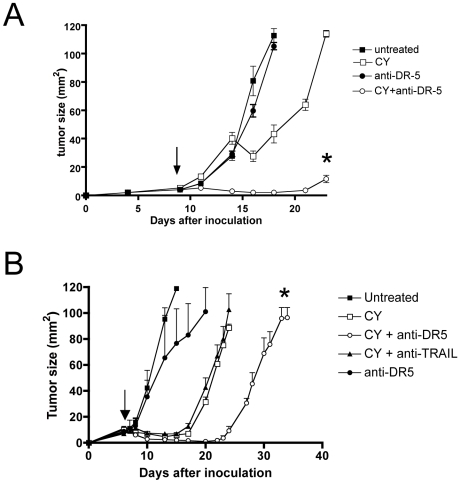
Rescue of CY anti-tumor efficacy in nude mice by anti-DR5 antibodies.Tumor-bearing athymic nude mice (inoculated at day 0) were treated with CY or with PBS at day 9 (a) or day 7 (b) after tumor cell inoculation and were treated with anti-DR5 antibody (clone MD5-1) or PBS at day 8, 12 and 16 after tumor cell inoculation. Data shown are mean±SEM (n = 5/group for each experiment). * P<0.05 when CY is compared with CY + anti-DR5. The effect of anti-TRAIL Ab without CY is shown in (b). Two mice were disqualified from the graph as they were found dead early in the experiment.